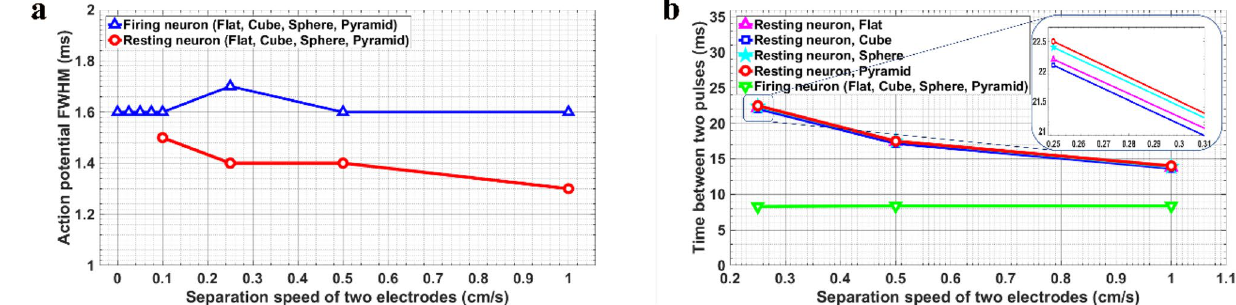
Figure 7. ( a ) FWHM of action potential during propagation. ( b ) Time delay between two consecutive